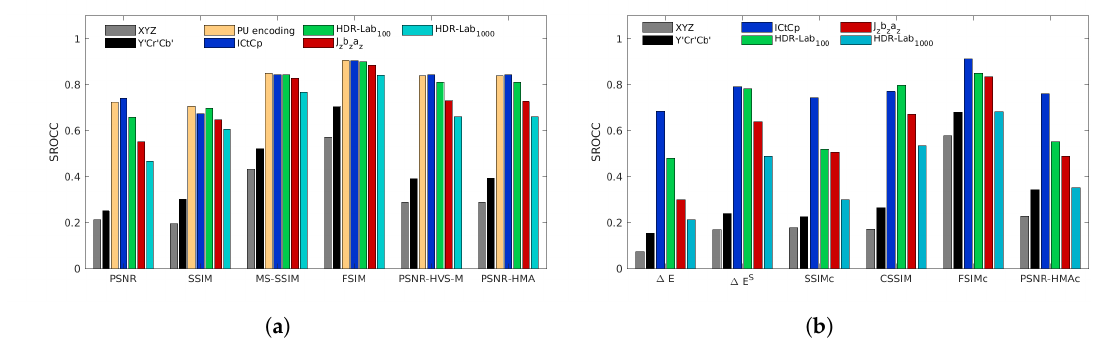
Figure 8. SROCC performances for the 4Kdtb database for color-blind quality metrics ( a ) and for color quality metrics ( b ).